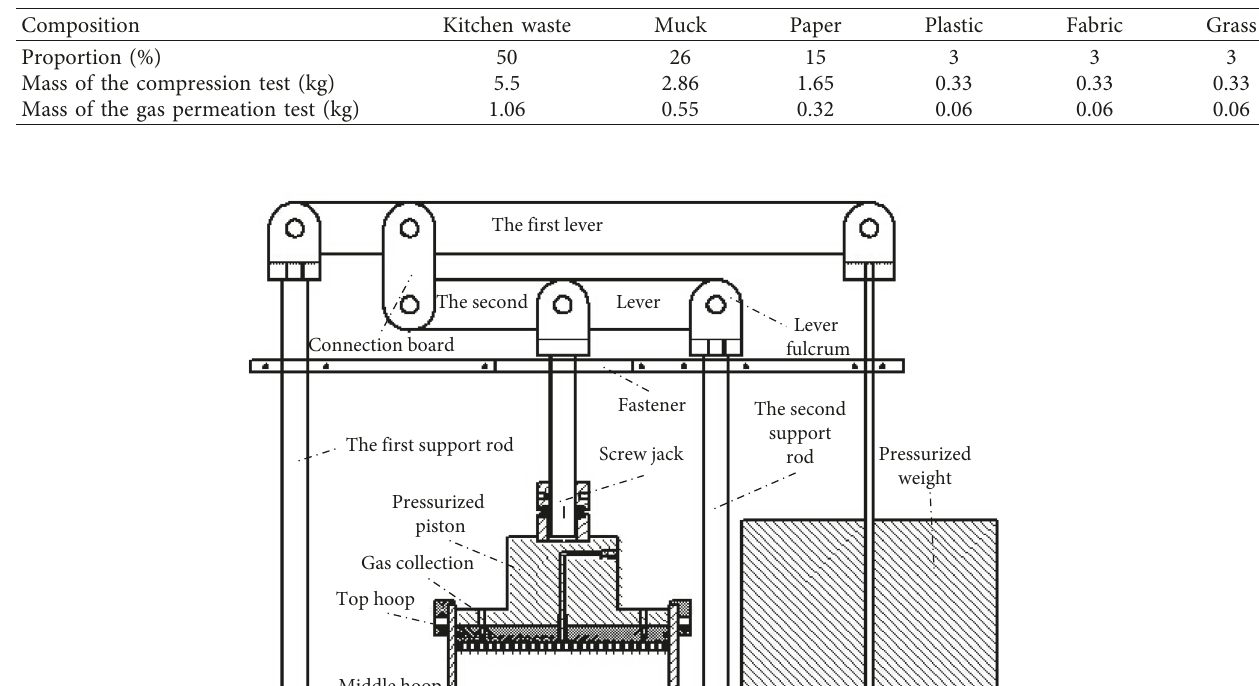
Table 2: Composition of MSW in the lab test.